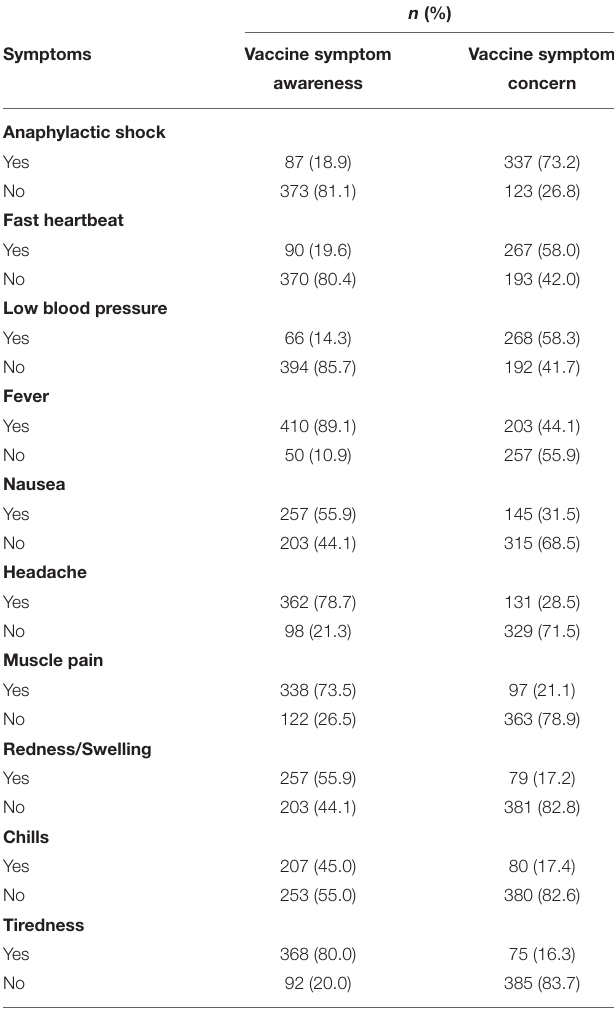
TABLE 3 | Awareness and concerns regarding side-effects of the COVID-19 vaccine.